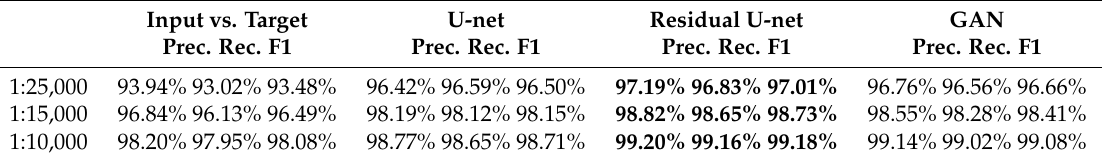
Table 2. Precision/Recall/F1-score on the positive class at three target map scale for the independent test